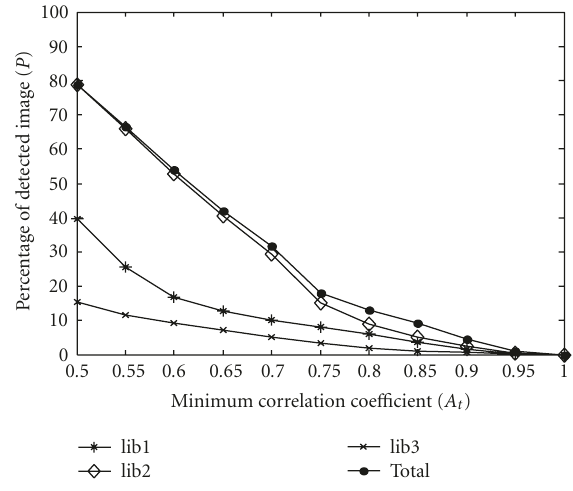
Figure 15: Relationship between the correlation values and percent- age of detected image ( P ) when e ff ective band selection strategy is used.